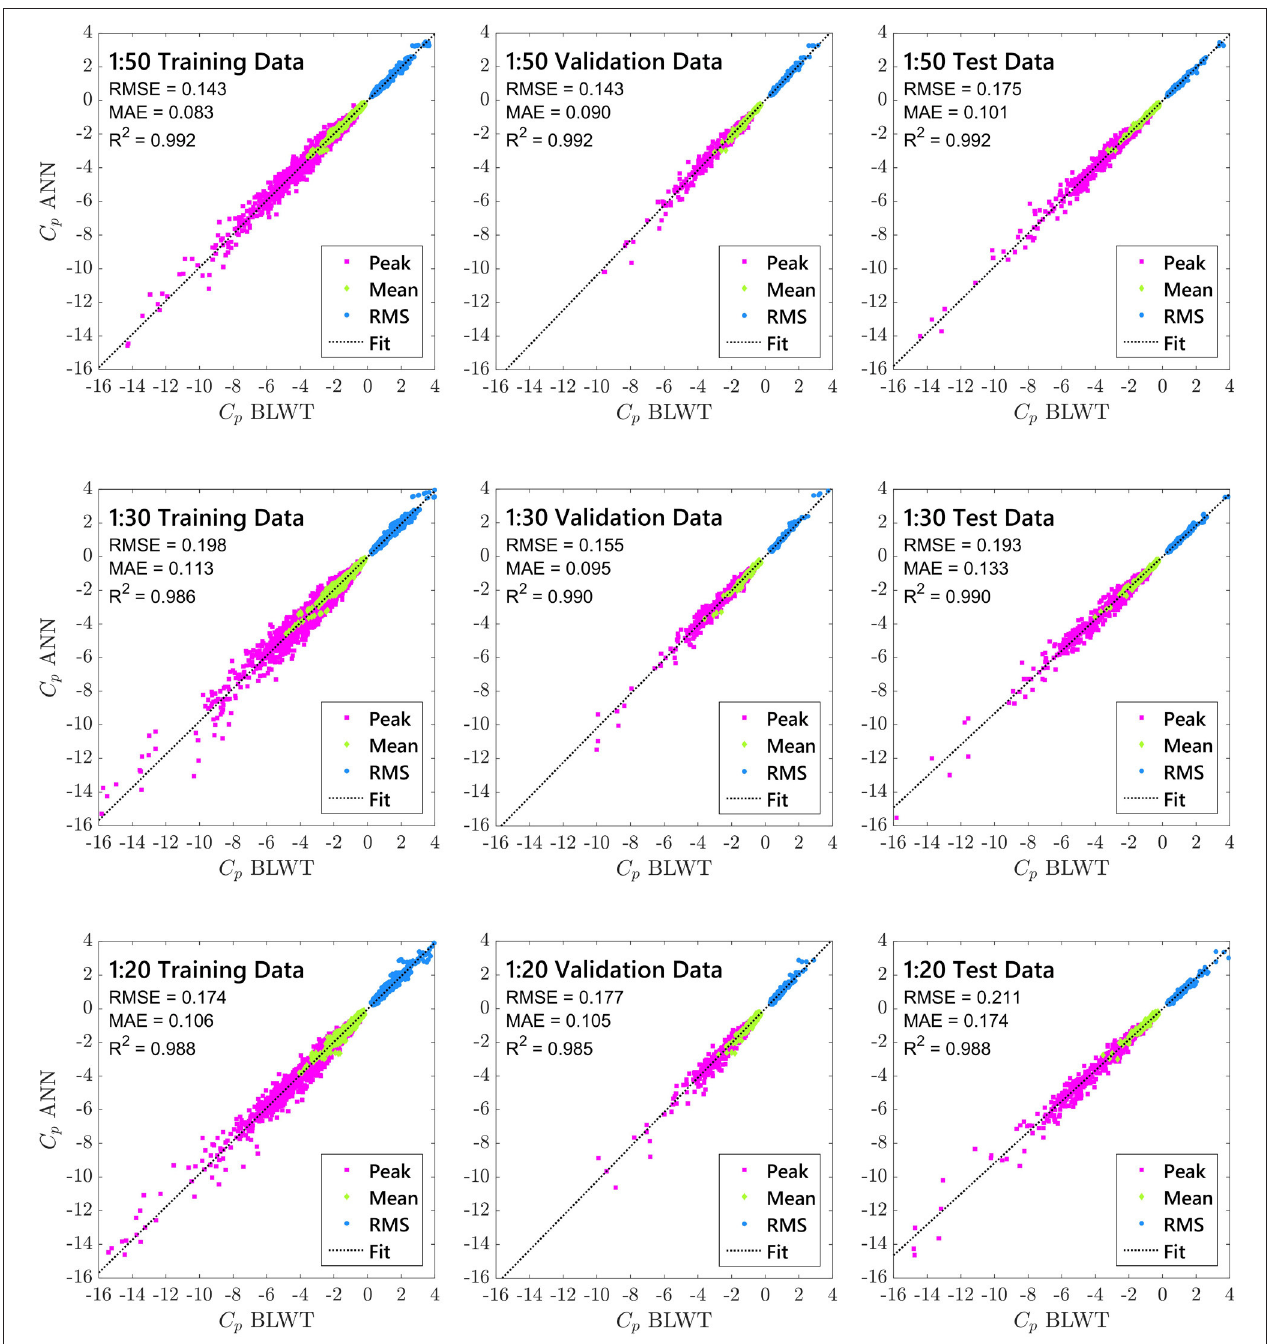
FIGURE 7 | ANN regression plots showing the relationship between the outputs ( C p ANN) of the network and the targets ( C p BLWT) for the three WERFL building models.